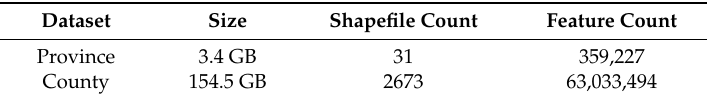
Table 3. The datasets for visualization.